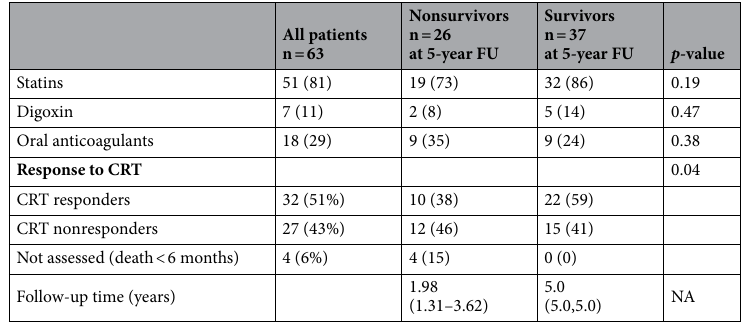
Table 1. Baseline demographic and clinical characteristics of the patients in the whole group, nonsurvivor group and survivor group. Values are expressed as the mean ± SD or counts and percent. *Values are expressed as the median with interquartile range (p25–p75). Gal-3, galectin-3; NYHA, New York Heart Association; LBBB, left bundle branch block; RBBB, right bundle branch block; eGFR, estimated glomerular